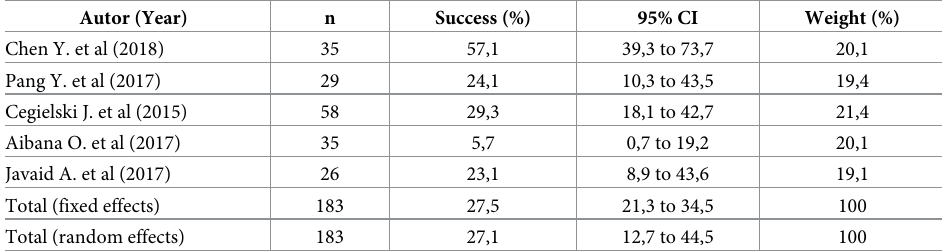
Table 3. Success rate in patients with